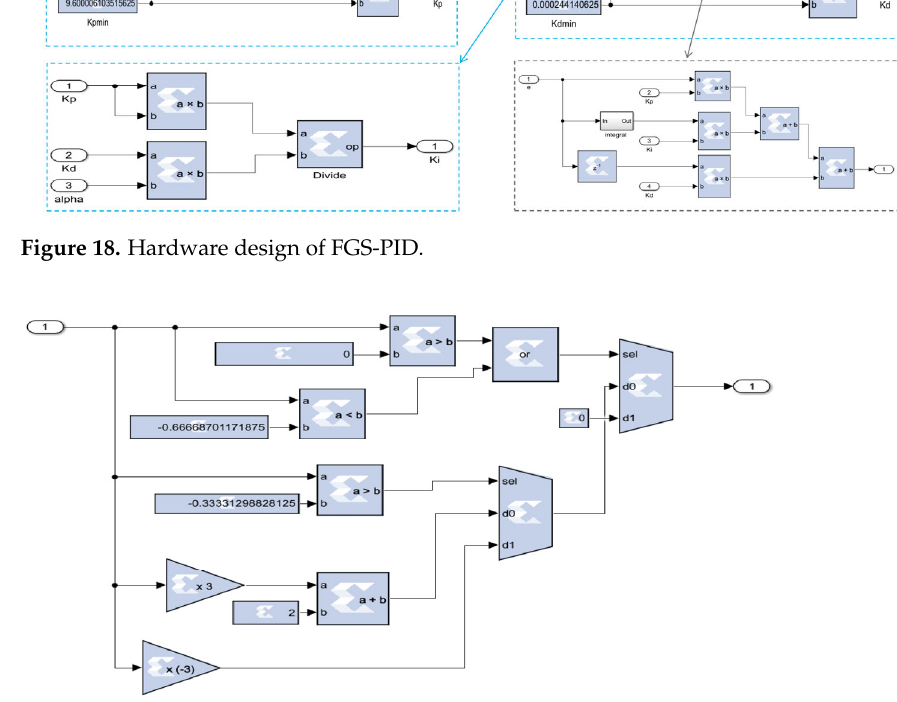
Figure 18. Hardware design of FGS-PID.